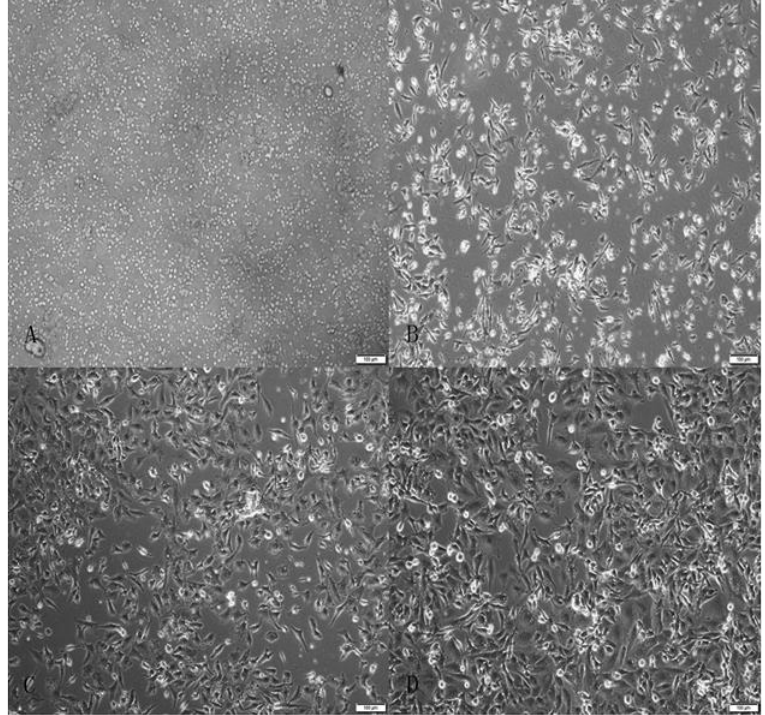
Figure 1. In vitro cultivation of granulosa cells. ( A ) Freshly isolated granulosa cells. ( B ) Granulosa cells cultured for 24 h. ( C ) Granulosa cells cultured for 48 h. ( D ) Granulosa cells cultured for 72 h.